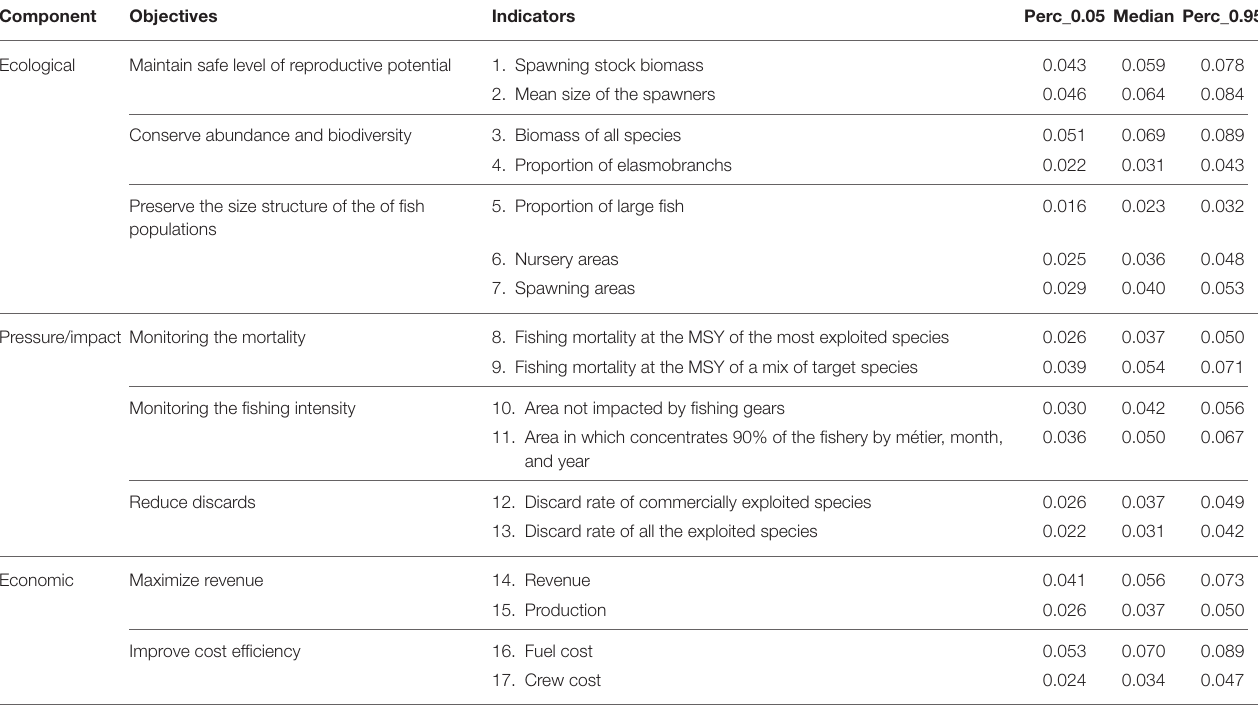
TABLE 2 | Survey 1 (Ranking preferences). Component